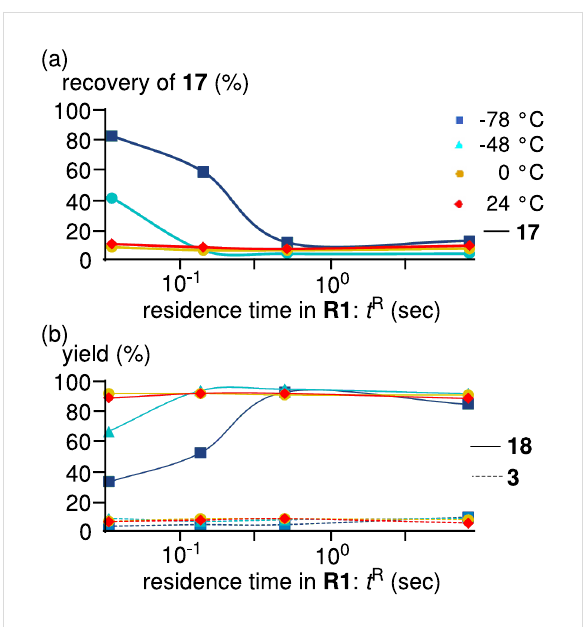
Figure 5: Effect of temperature and residence time in Br-Li exchange reaction of 4,4′-dibromobiphenyl ( 17 ) using the microflow system; (a) Plots of recovery of 17 against residence time, (b) Plots of yields of 18 and 3 against residence time. Flow rate of a solution of 4,4′-dibromobi- phenyl ( 17 ): 6.00 mL·min −1 , flow rate of n -BuLi/hexane: 1.20 mL·min −1 , flow rate of methanol: 3.00 mL·min −1 . Yields of 3 , 17 and 18 were determined by